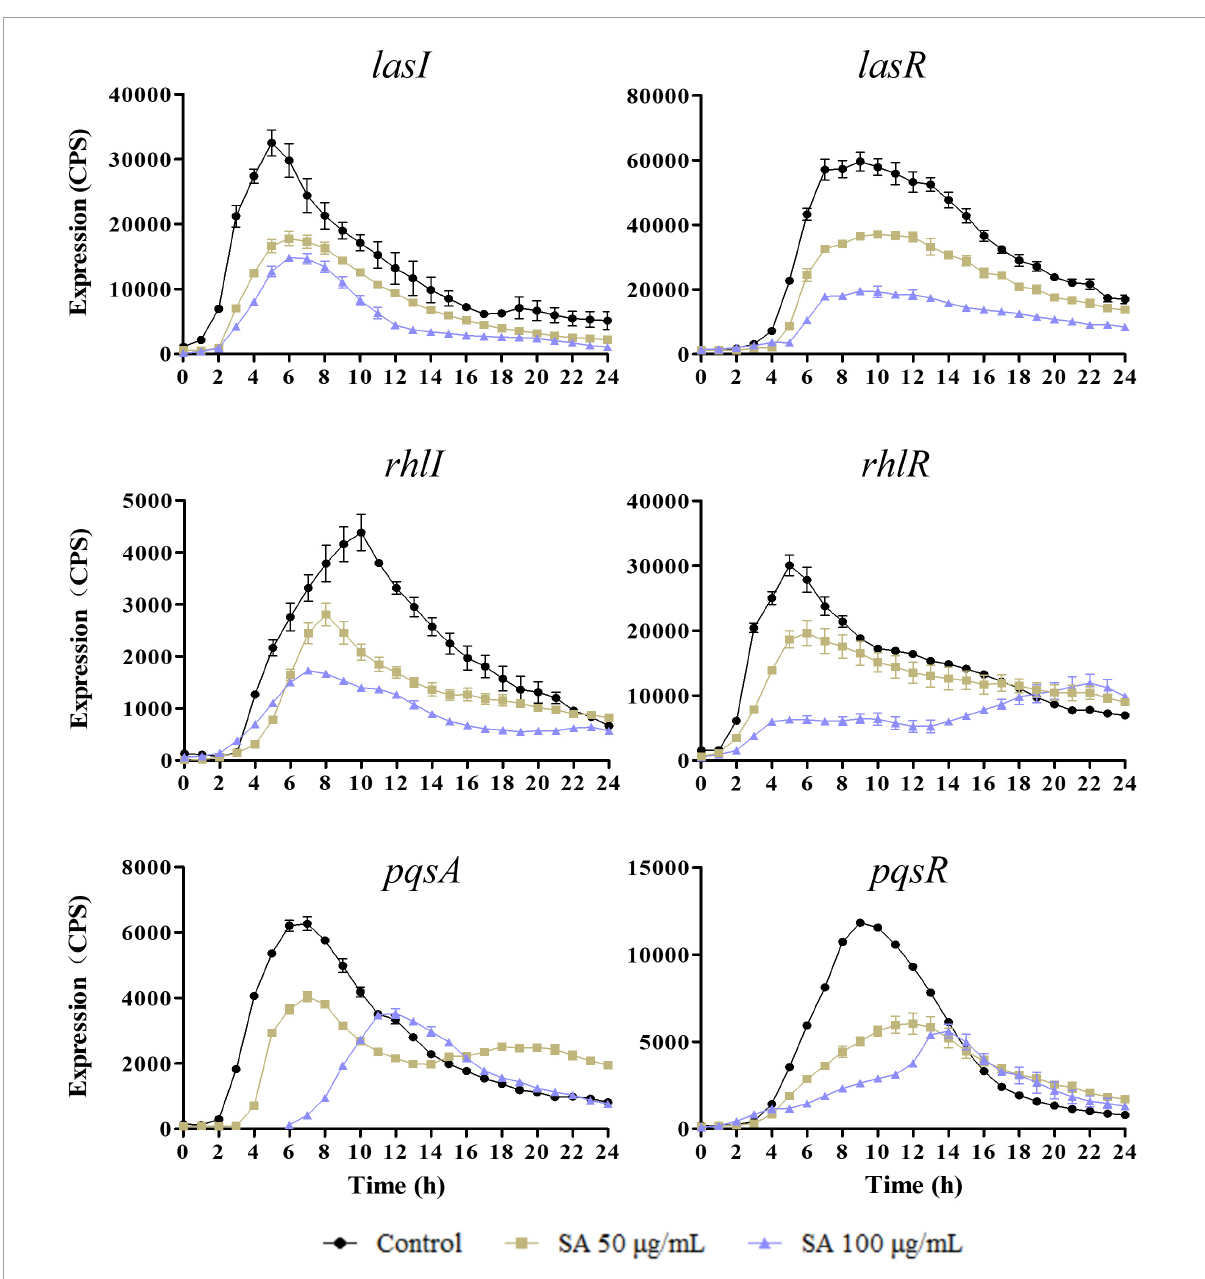
FIGURE2 Sennoside A inhibits the expression of QS-regulated genes ( lasI , lasR , rhlI , rhlR , pqsA , and pqsR ) in PAO1. All data were expressed as mean ± SD values with three independent experiments performed in triplicate.